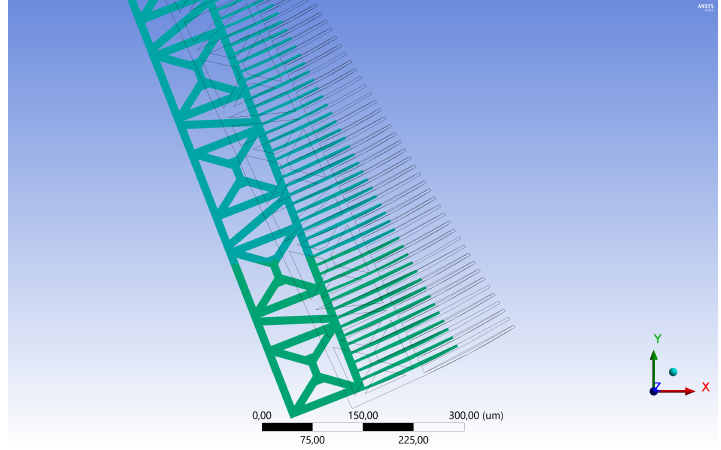
Figure 10. Critical configuration of the comb drive fingers when mode (v) is